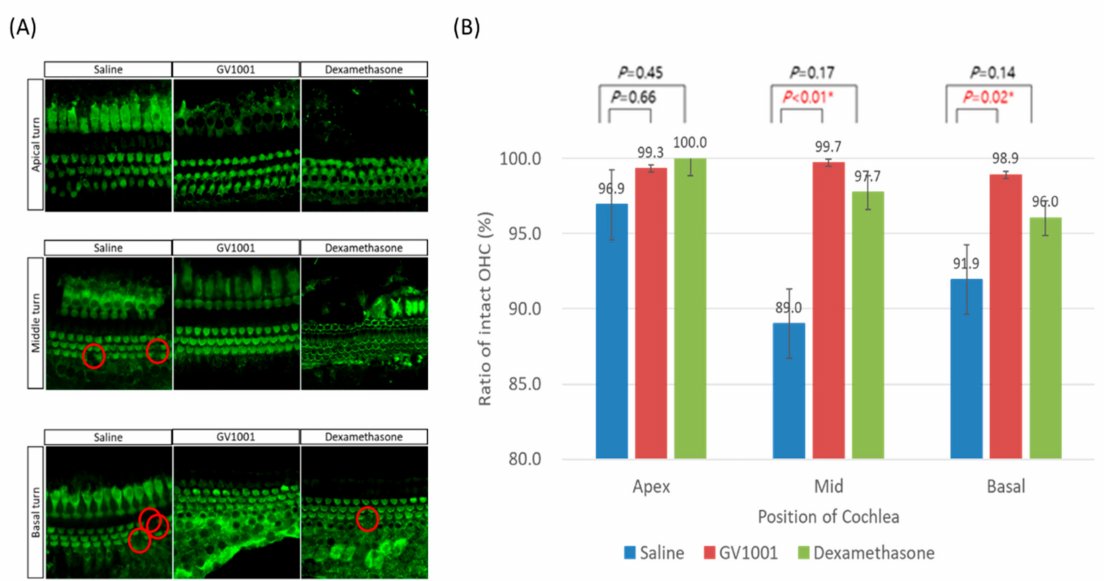
Figure 3. E ff ect of GV1001, dexamethasone and saline treatment in NIHL murine model induced by severe permanent threshold shift (PTS)-noise. ( A ) Representative images of myosin-VII-labeled hair cells in each cochlear turn on day 14 after severe PTS-noise exposure. Red circles indicate lost outer hair cells (OHCs). Scale bar: 10 µ m. ( B ) Survival rate of the OHCs according to di ff erent systemic injection after cessation of severe PTS-noise. The Error bars in threshold shift panels are SEM. All groups contained 17 mice.* p < 0.05 (by one-way ANOVA with the Tukey post-hoc